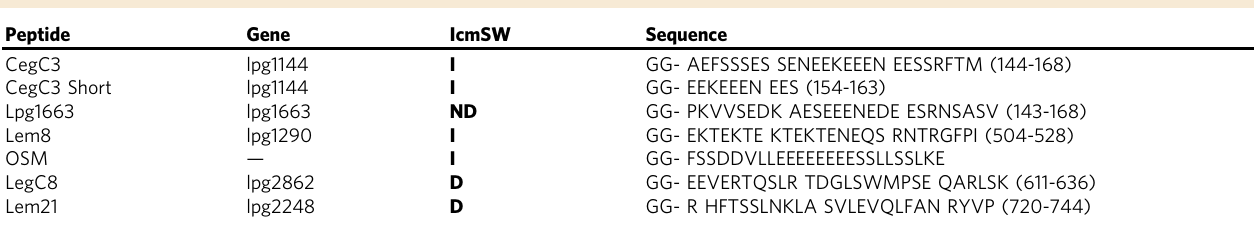
Table 2 Peptides used in this study